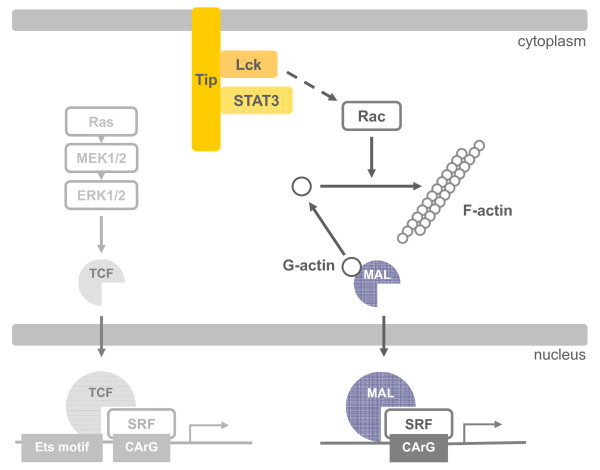
Model for Tip-induced SRF activation. The membrane-associated viral oncoprotein Tip engages and activates the Src-family kinase Lck. This interaction is required for STAT3 phosphorylation and for MAL:SRF activation. Signaling flux from Tip:Lck to the RhoGTPases Rac remains to be established (dashed line). Rac promotes a decrease in the G-actin/F-actin ratio and thereby enables nuclear translocation of MAL and coactivation of SRF-dependent gene expression. Tip:Lck is not linked to Ras, MEK1/2, or ERK1/2 and subsequent TCF activation